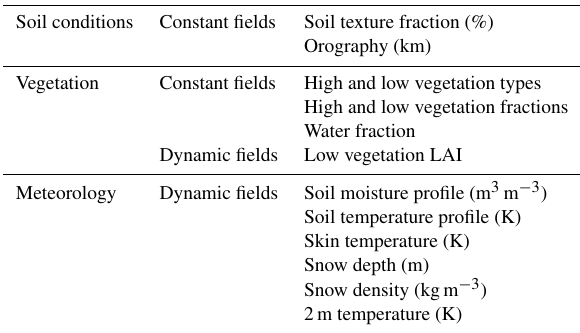
Table 2. Input variables for the CMEM to compute TBs at